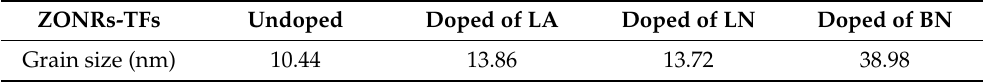
Table 3. Grain sizes of undoped and LA-, LN-, and BN-doped (2 wt.%)